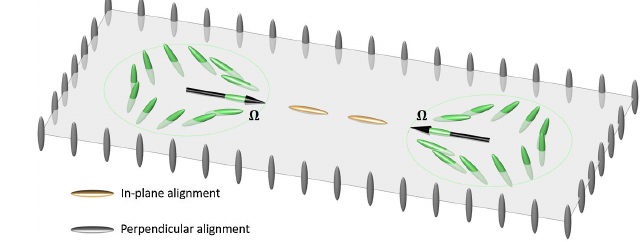
FIG. 5. Adjacent twist-type surface defects (green) tend to align antiparallel to each other in contractile systems to minimize the region of in-plane alignment. This alignment results in lines of planar surface anchoring between the defects (orange